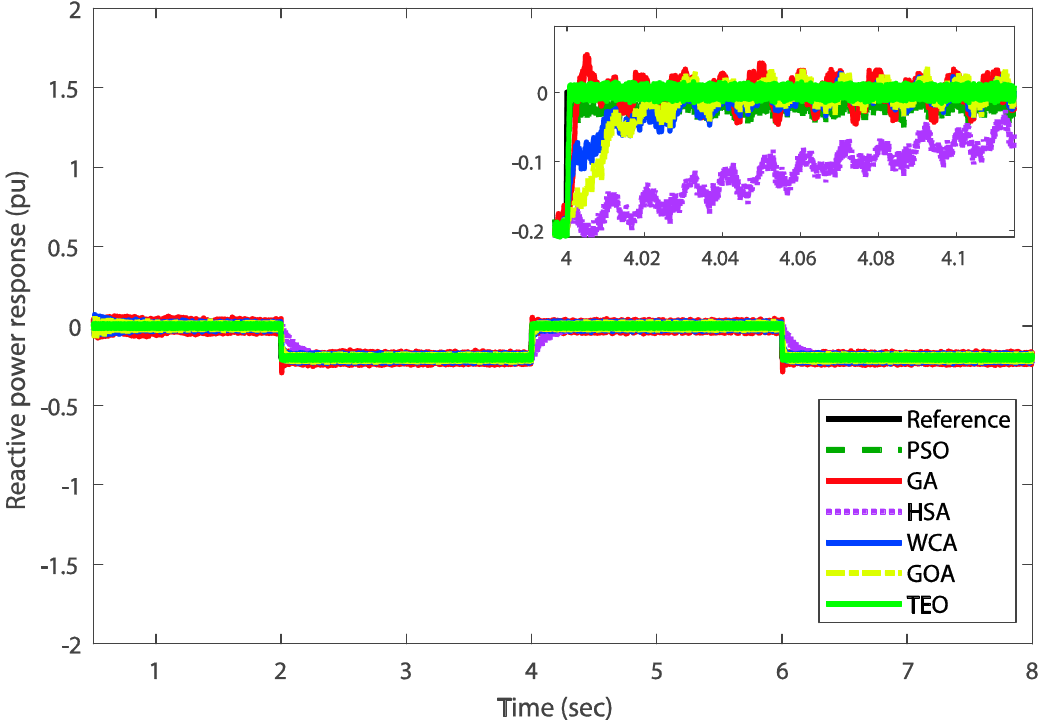
Figure 14. Performance comparison of the controlled reactive power under different PI controllers’ tuning methods.